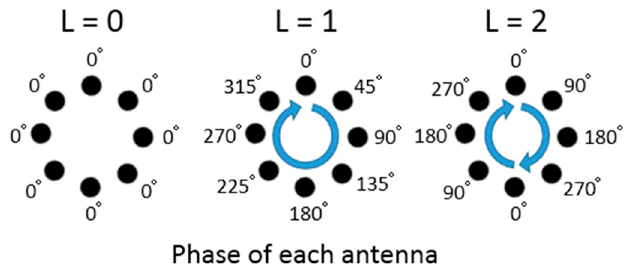
Figure 1. Generation of OAM modes by a uniform circular array.